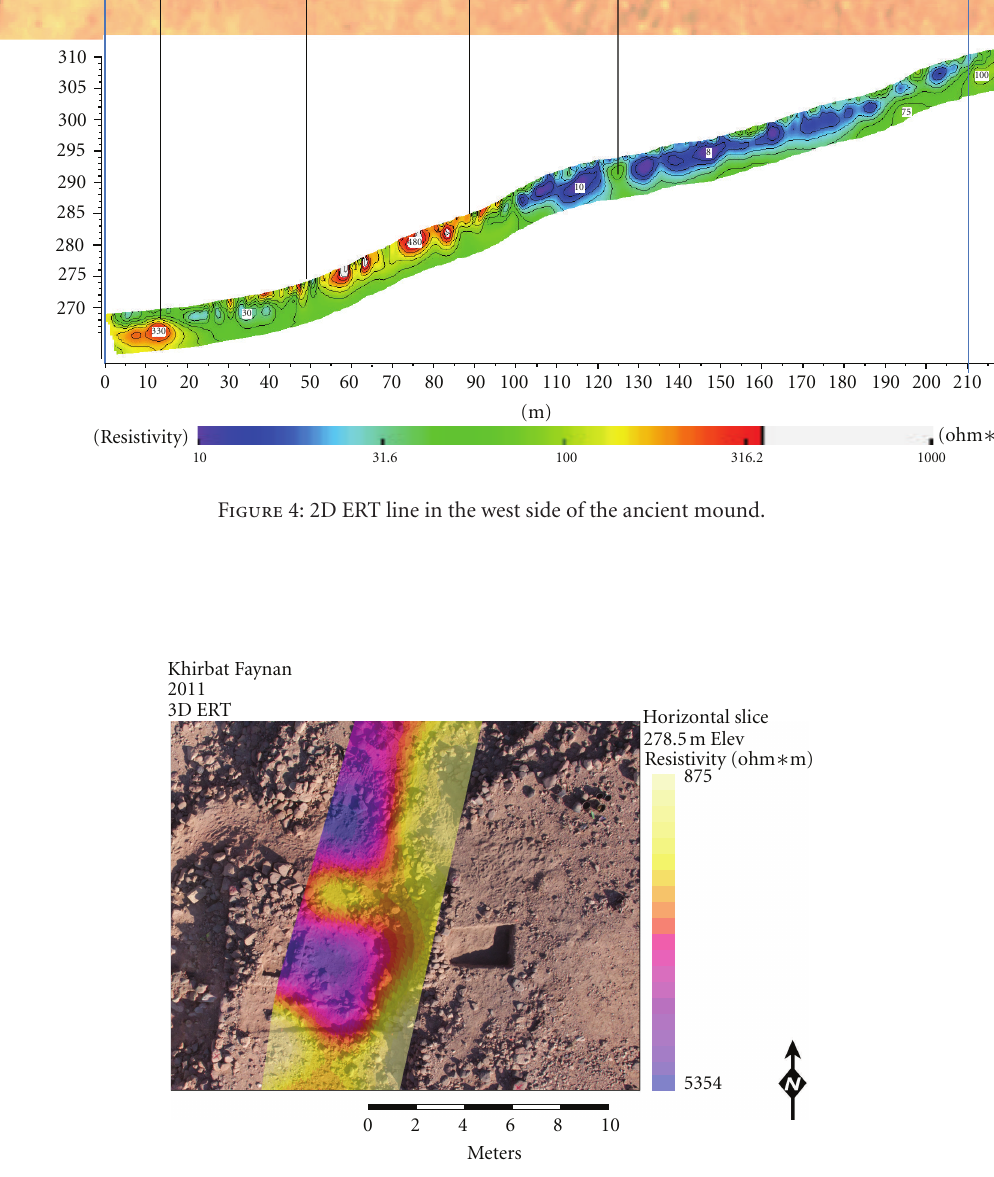
Figure 5: Semitransparent horizontal ERT slice at 1m depth, overlaid on top of an aerial image of the